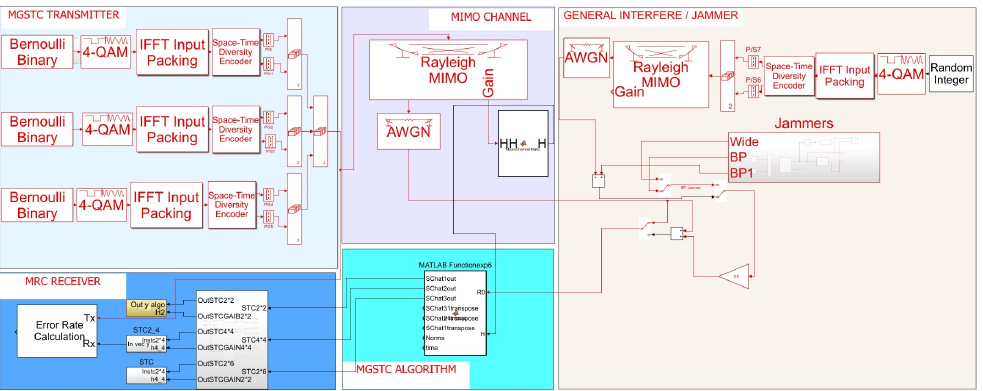
Figure 2. Scheme blocks of the simulation of the MGSTC algorithm based on the SIMULINK/MATLAB